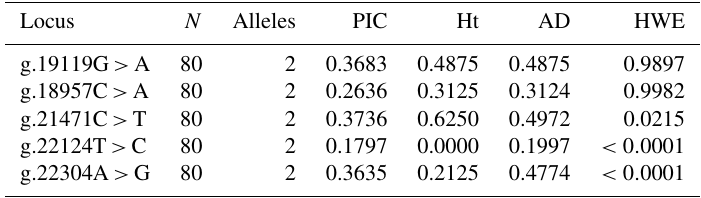
Table 4. Population genetic variability of native Indian pig using targeted SNPs of porcine MUC13 gene. Locus